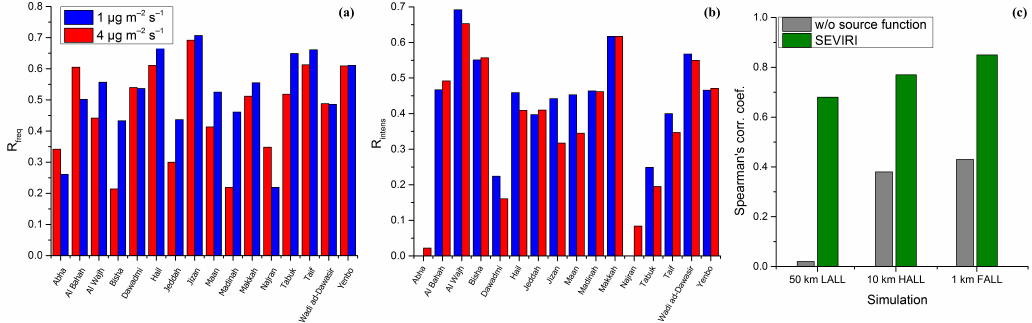
Figure 3. Spearman’s correlation coefficients for monthly-mean series of (a) dust event frequency and (b) intensity between station data and results from 10kmALL experiment. (c) Spatial metrics of model performance (see text for definition) for three basic experiments with and without SEVIRI source